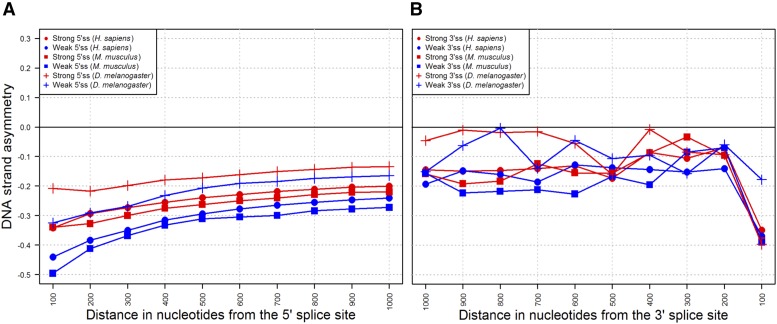
DNA strand asymmetry of the polyadenylation AATAAA motif (DSAAATAAA) in 100-nt intronic segments at increasing distances from low- and high-scoring upstream 5′ss (A) and downstream 3′ss (B). DSAAATAAA was computed for samples that consist of ≥500 sequences. Low and high 5′ss (3′ss) scores are the lower and the upper quartile, respectively, of the 5′ss (3′ss) strength distribution generated for each of the species surveyed (human, mouse, and D. melanogaster).